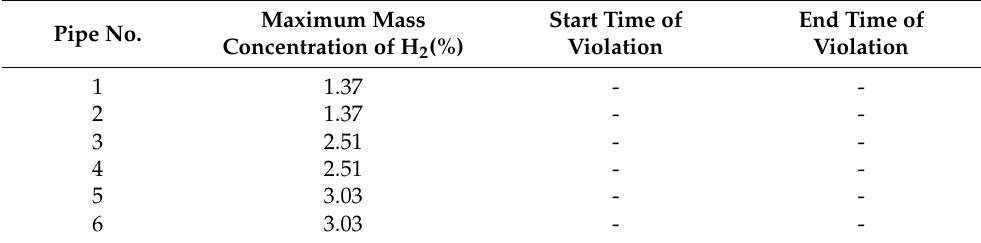
Table 2. The results of hydrogen concentration violation of each pipe in Scenario II. Pipe No.